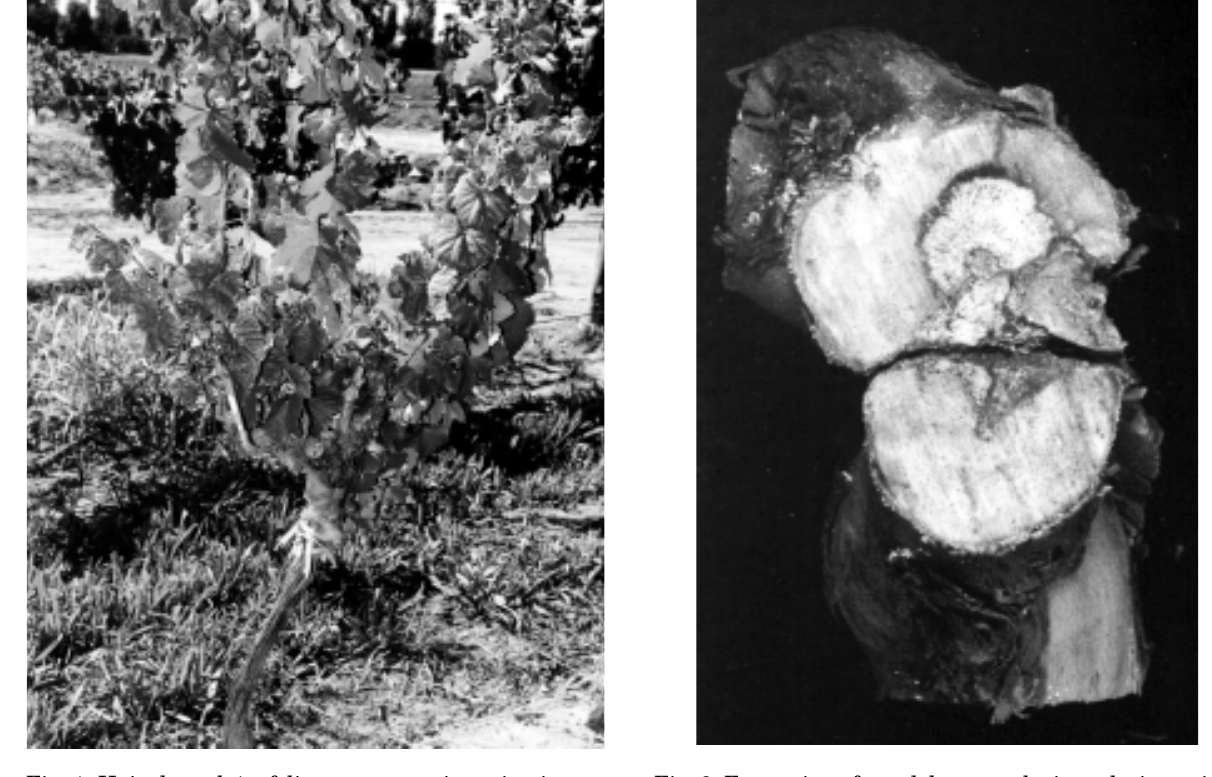
3).Fig. 1. Hoja de malvòn foliar symptoms in a vine inocu- lated (vine No. 3) with Phellinus